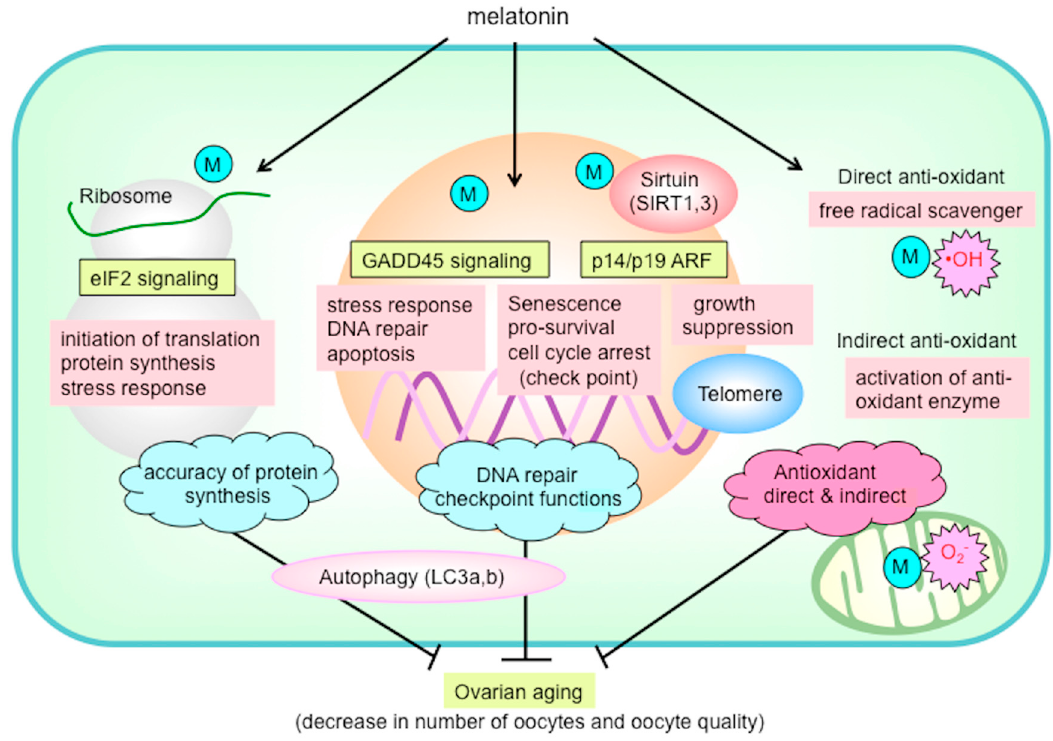
Figure 4. The possible mechanism of melatonin to prevent ovarian aging. Melatonin is likely to reduce ovarian oxidative stress not only by its direct action as a free radical scavenger but also by its indirect action of enhancing the antioxidant enzyme activity. Melatonin enhances eukaryotic initiation factor 2 (eIF2) signaling, which is essential for translation initiation and protein synthesis in ribosomes, and growth arrest and DNA-damage-inducible 45 (GADD45) signaling, which is involved in DNA repair and checkpoint functions. Melatonin also suppresses autophagy-related protein (light-chain 3a, 3b: LC3a, LC3b) by enhancing intracellular pathways including eIF2, GADD45, and alternative reading frame (ARF) pathways. The mRNA expression of sirtuin longevity genes ( SIRT1, SIRT3 ) and telomere length were also enhanced due to melatonin treatment. Melatonin delays ovarian aging by multiple mechanisms including antioxidant action, DNA repair, maintaining telomeres, SIRT family activity, ribosome function, and autophagy. M: melatonin; O 2• − : superoxide anion; OH: hydroxyl radical